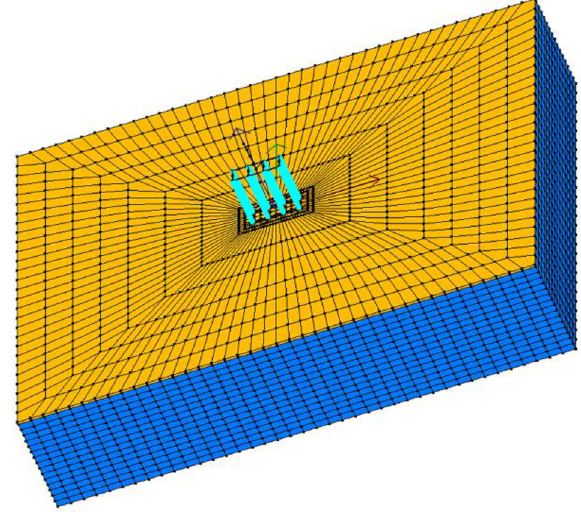
Figure 1. 3D model: uniform soil layer (blue), infill (yellow).